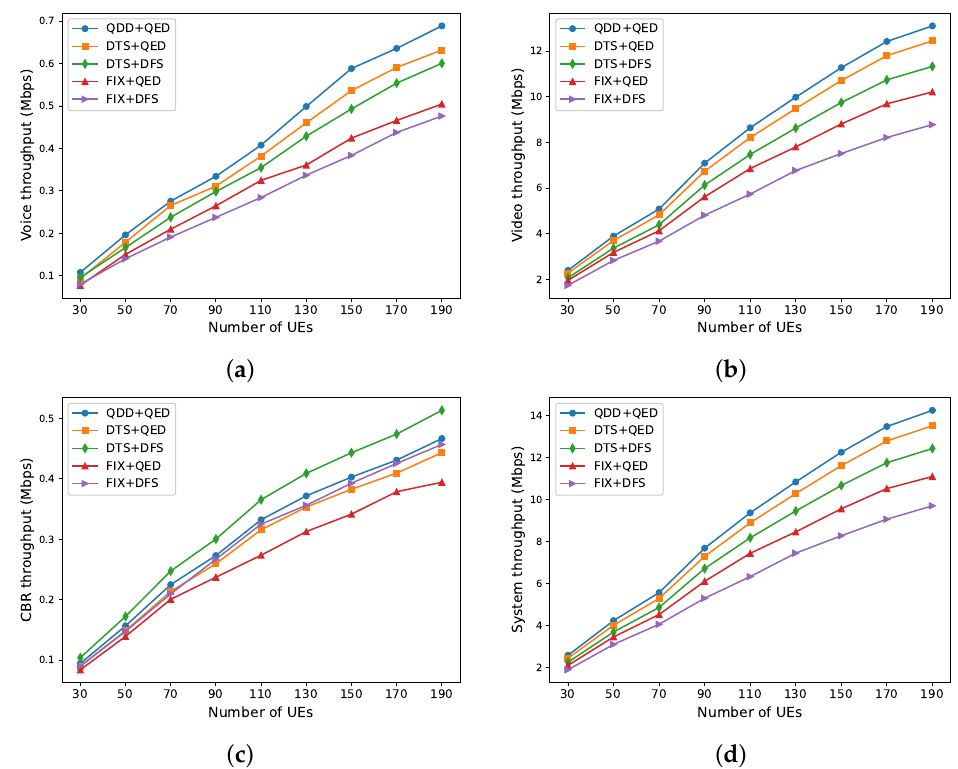
Figure 4. Simulation results on ( a ) voice, ( b ) video, ( c ) CBR, and ( d ) system throughput when varying number of